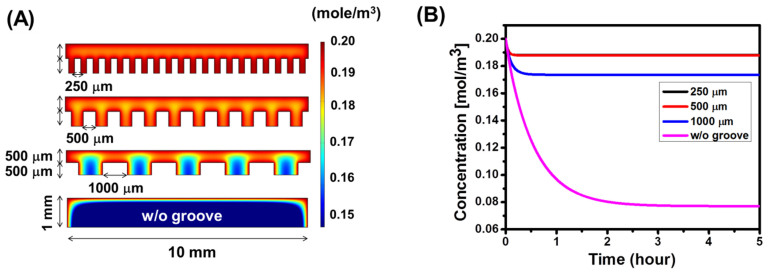
Computational simulation of oxygen distribution in a hydrogel.(A) Two-dimensional distribution of oxygen within cell-encapsulated hydrogels with grooves of different spacing at 250 (top), 500 (middle), and 1,000 μm (bottom). The gel immersed in cell culture media over five hours was simulated. A hydrogel with 1 cm-diameter and 1 mm-thickness was presumed to encapsulate 200,000 cells. The scale bar on the right side represents the oxygen concentration (mol/m3). (B) Estimated change of a net oxygen concentration in a hydrogel over time balanced by the diffusion into the gel and the consumption by encapsulated cells.